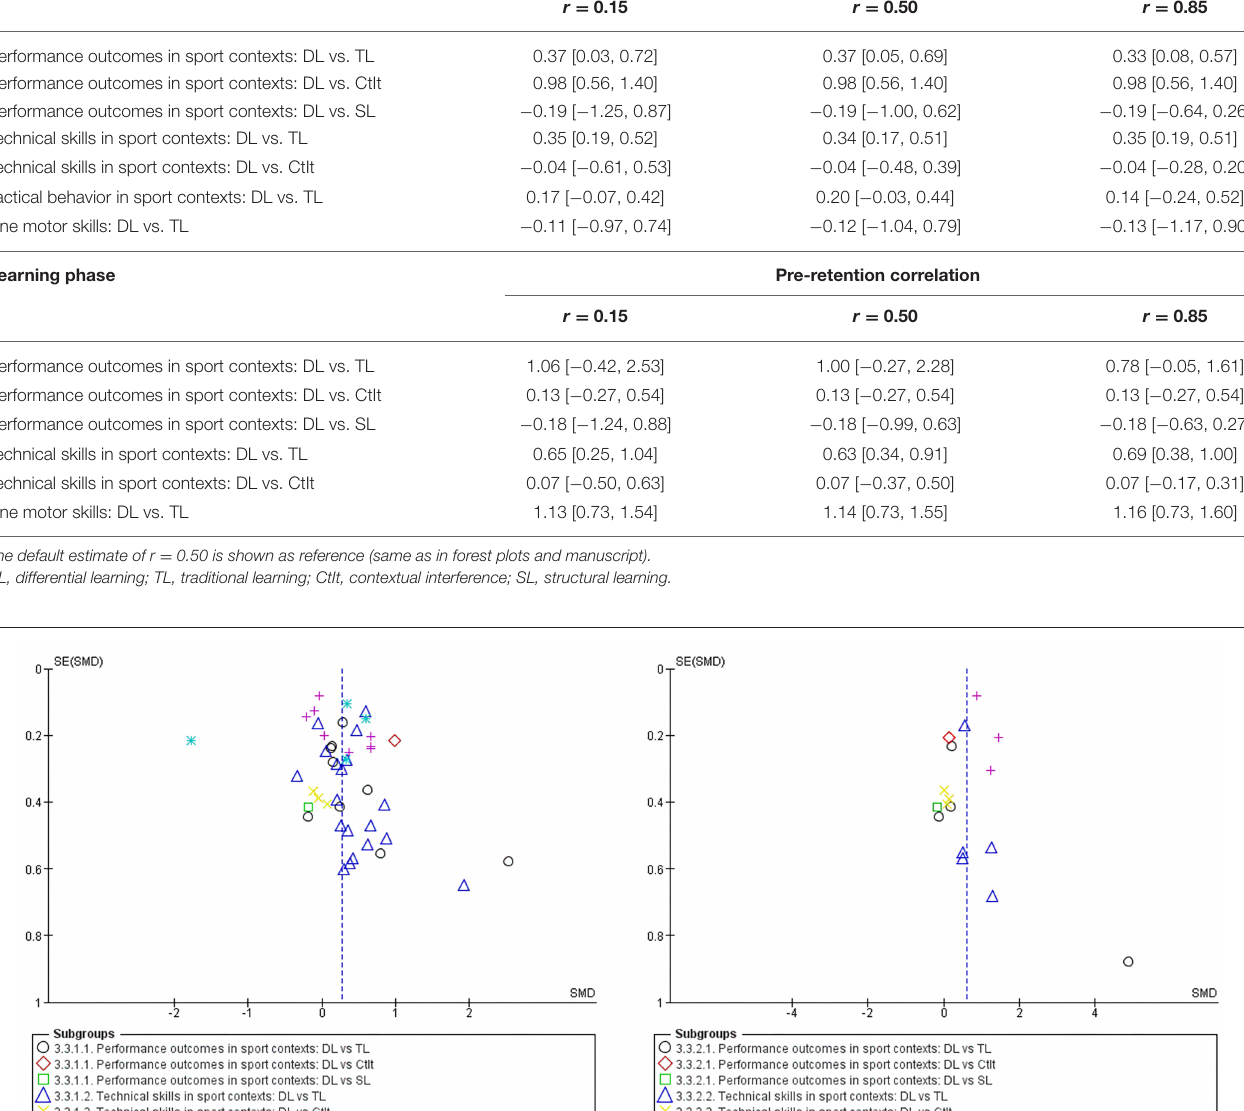
TABLE 3 | Sensitivity analysis of the effect sizes [95% CI] based on various levels of the pre–post correlation coefficient. Acquisition phase